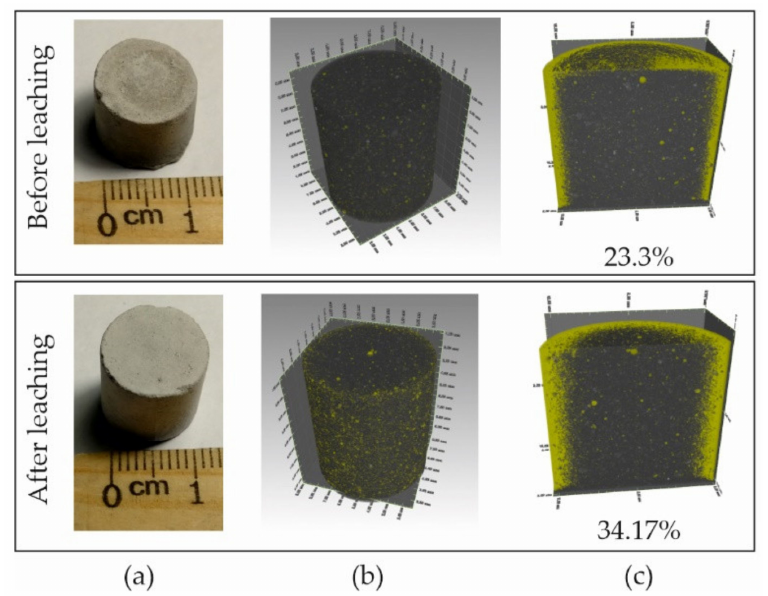
Figure 2. The change in the porosity of concrete samples. ( a )—photo of a concrete sample before and after leaching; ( b )—model of concrete cylinder obtained from µ CT; ( c )—relative porosity, identified using computer microtomography (% of the